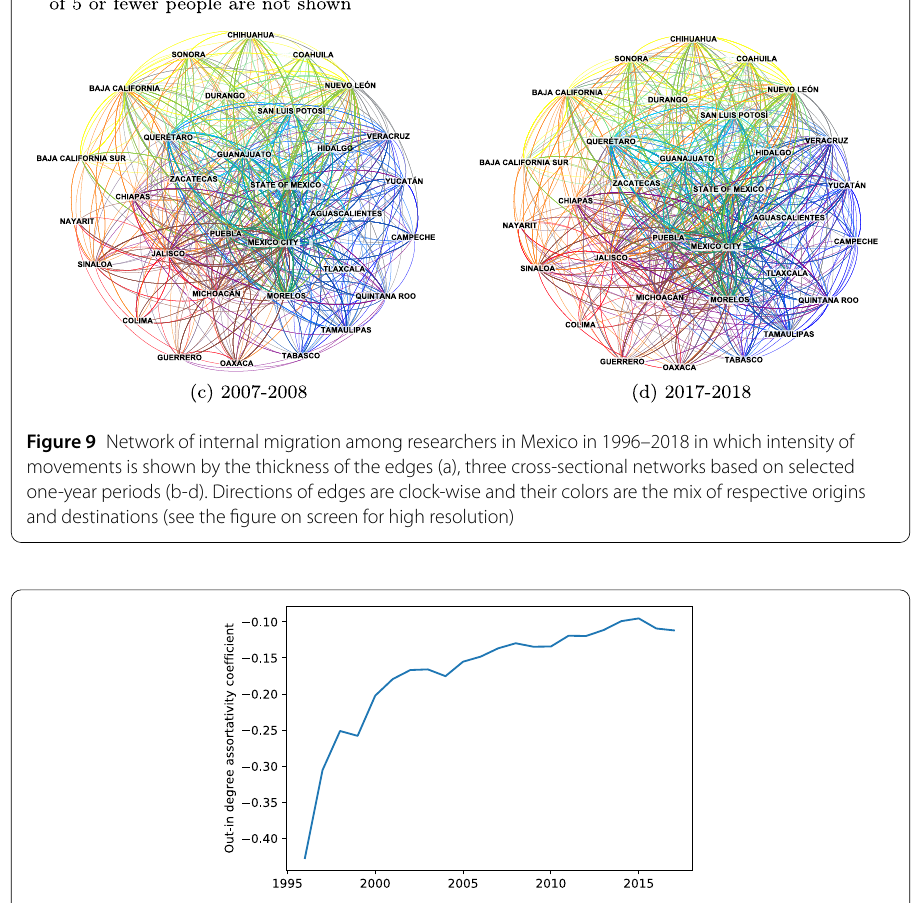
out of a vertex of out-degree k . The term q in degree) distribution [41] of directed graph G and σ in ( σ out ) is the standard deviation of the ( q out distribution q in j k